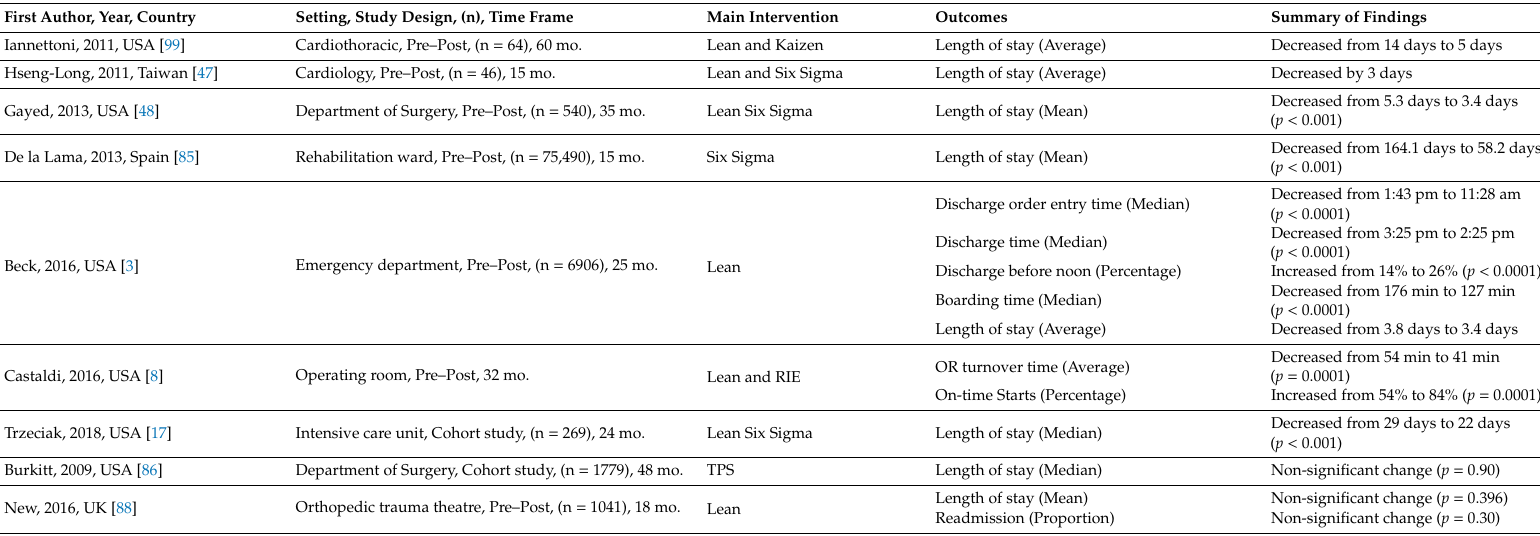
Table 2. Main Outcomes of Lean Healthcare